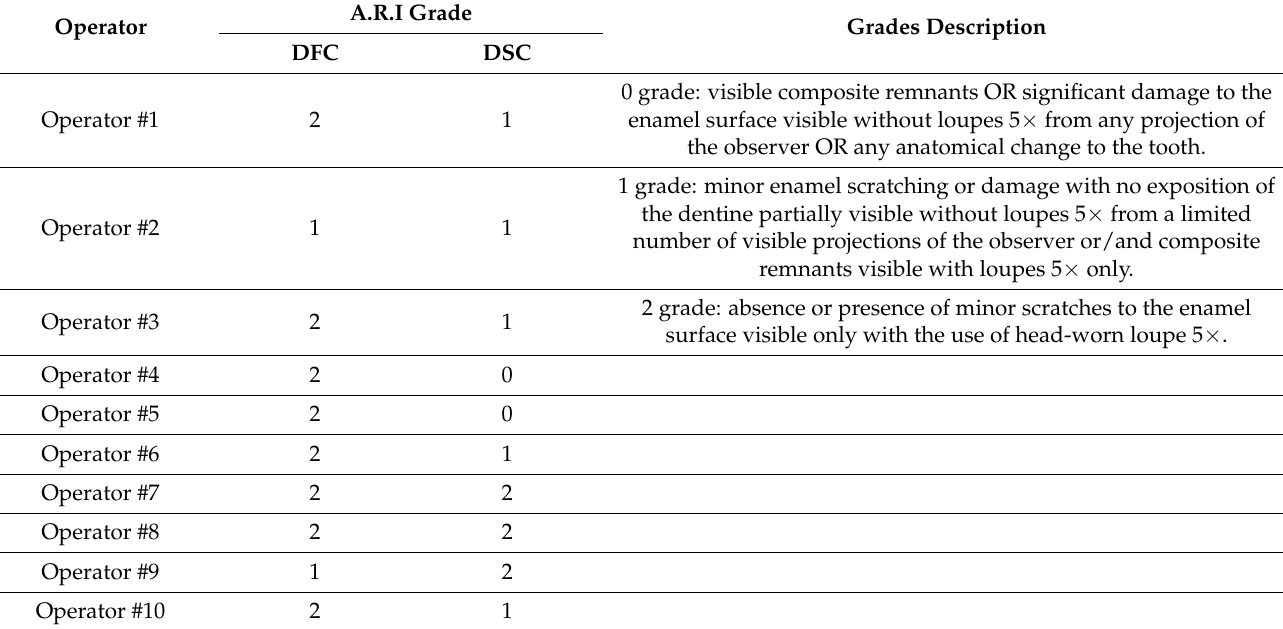
Table 2. Modified ARI